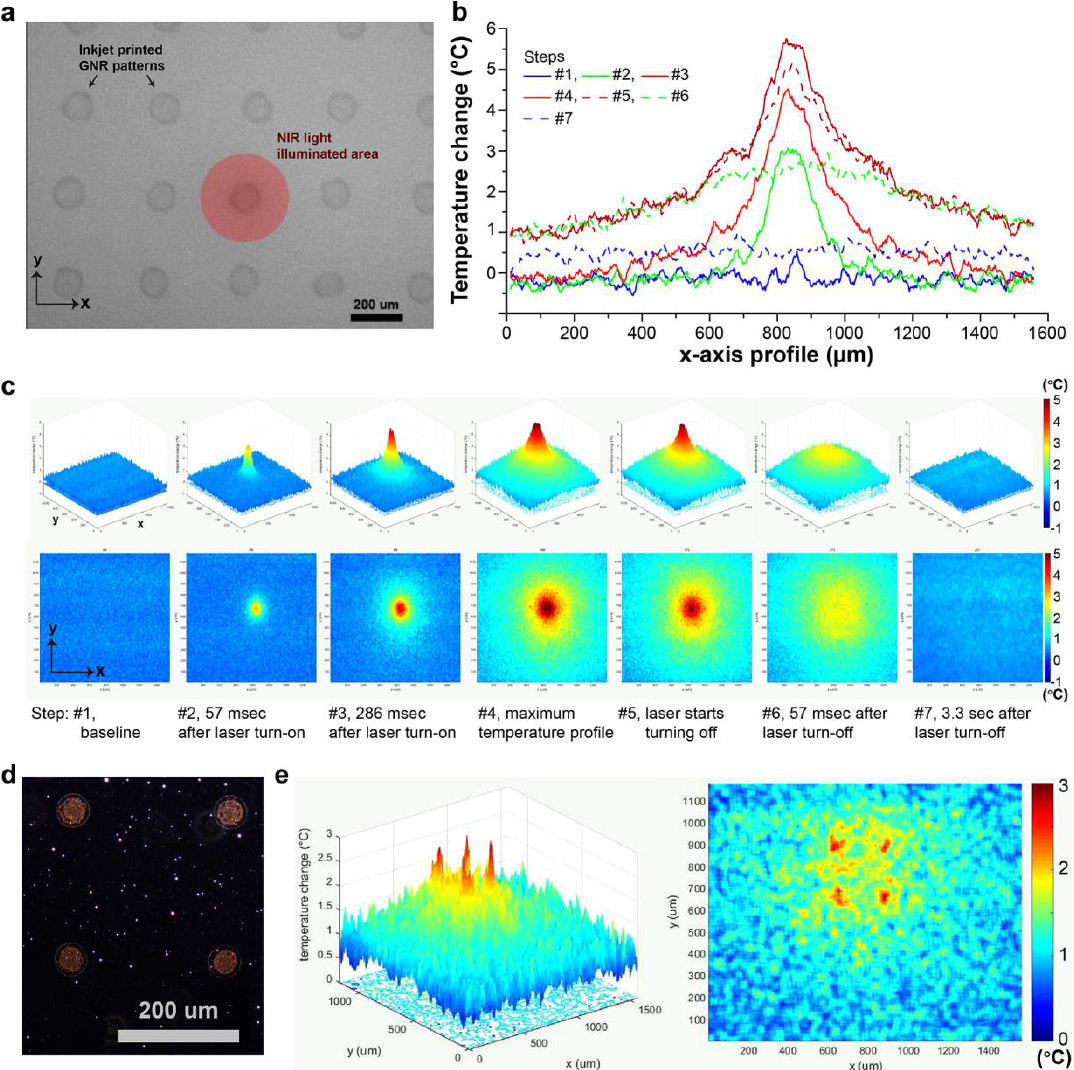
Figure 13. Heat generation by inkjet-printed micro-thermo-plasmonic ( µ TP) heaters. ( a ) Experimental setup: inkjet-printed GNR µ TP pattern array on PAH + -coated glass coverslip via a 50- µ m inkjet nozzle with 350- µ m drop spacing. An 808-nm NIR laser with a 1.38 W / mm 2 power density is illuminated only on a single dot pattern. Image spatial resolution: 2.4 µ m / px. ( b , c ) 2D and 3D profiles of temperature change around a µ TP heater in ( a ). Gaussian profile heat source formed within 300 ms after the NIR laser was turned on (step 3); the overall temperature increased due to heat dissipation from the heater (step 3 to 4), and the heat source rapidly vanished when the laser was turned o ff (steps 5, 6). ( d , e ) Smaller µ TP heaters (dark-field image) and their heat profiles at their highest temperature change (diameter: 45 µ m, drop spacing: 250 µ m, inkjet nozzle: 30 µ m, droplet volume: ~5 pL, NIR laser power density: 1.16 W / mm 2 ). Reproduced with permission from [18]. American Chemical Society, 2018.